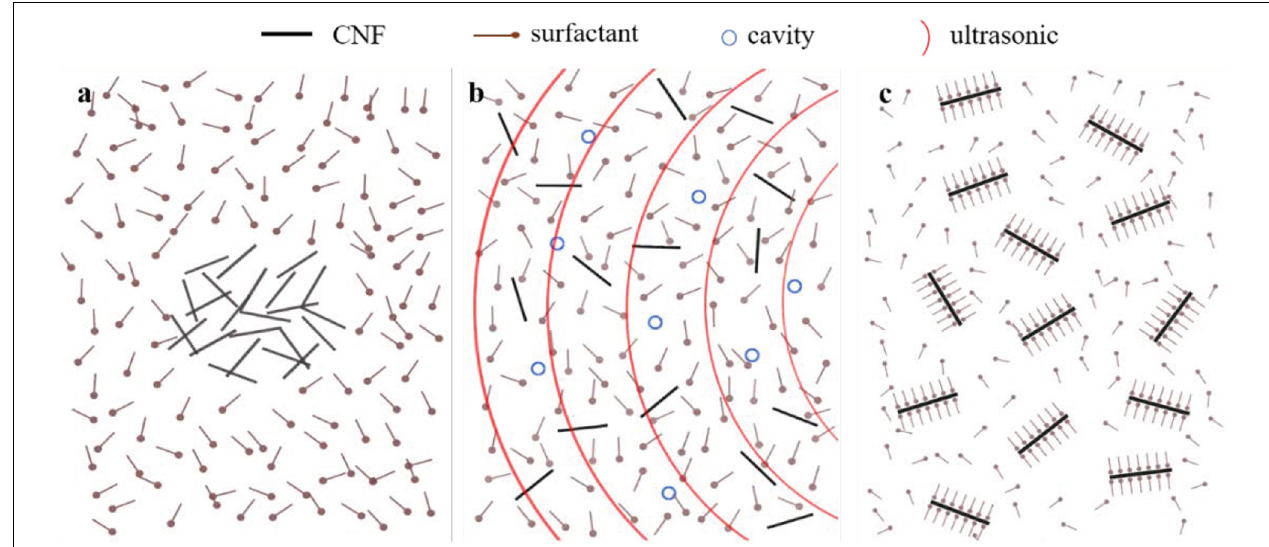
FIGURE 2 | Dispersion process: (a) unprocessed (b) during process (c) after process.